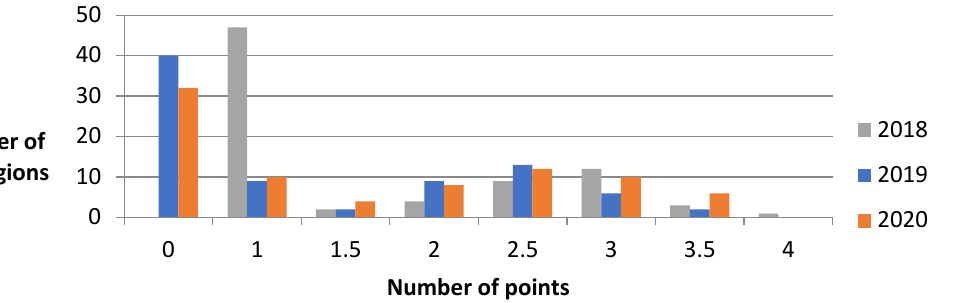
Figure 5. The total score of the staffing of organisations providing rehabilitation and/or habilitation services with specialists of the appropriate profile based on the needs of PwD in rehabilitation and/or habilitation services.